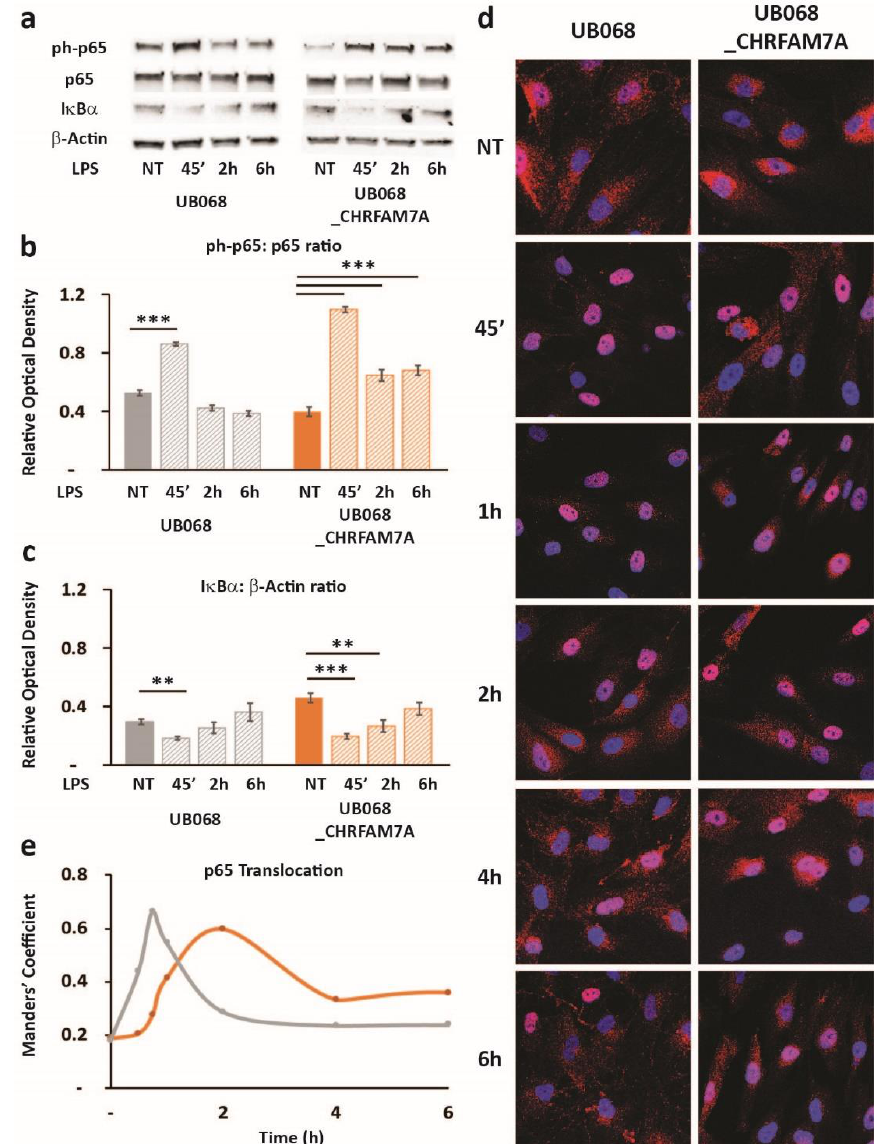
Figure 5. Hypomorphic CHRFAM7A caused NF- κ B inhibition, resulting in a proinflammatory switch: ( a ) Immunoblots showed an increase in p65 (RelA) phosphorylation and a decrease in I κ B α in response to the LPS treatment (1 µ g / mL) in the UB068 and UB068_CHRFAM7A lines. Densitometric analysis of the phospho-p65 (Cell Signaling Technology, Cat# 3033) and p65 ( b ) and I κ B α ( c ) expression levels in the untreated and LPS-treated (1 µ g / mL; 45 (cid:48) , 2 h, 6 h) MGL cells derived from the UB068 and UB068_CHRFAM7Alines. Dataarepresentedasmean ± SD.** p < 0.01, *** p < 0.001( t -test)—di ff erencein theLPS-inducedinflammatoryresponseincomparisontonon-treatedcontrols( n = 5). ( d